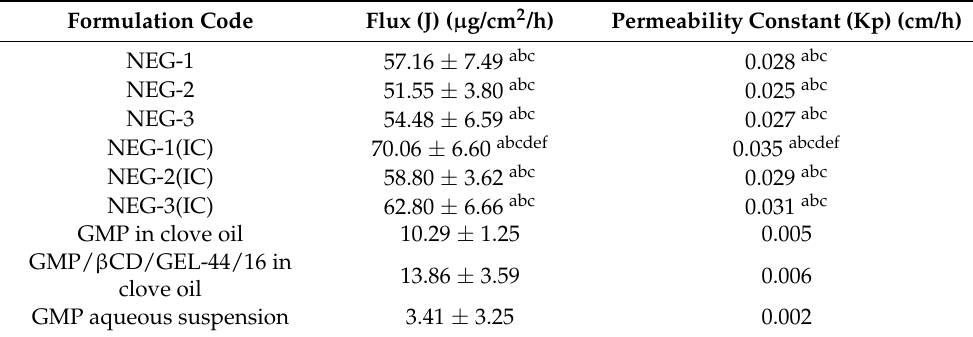
Table 7. Permeation parameters of GMP- and GMP/ β CD/GEL-44/16-loaded nanoemulsion-based gels (Mean ± SD, n = 3). Formulation Code Flux (J) ( µ g/cm 2